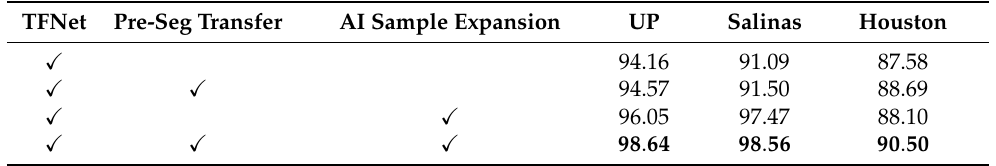
Table 7. Classification accuracy of ablation experiments for three datasets. (The best results are represented in bold).